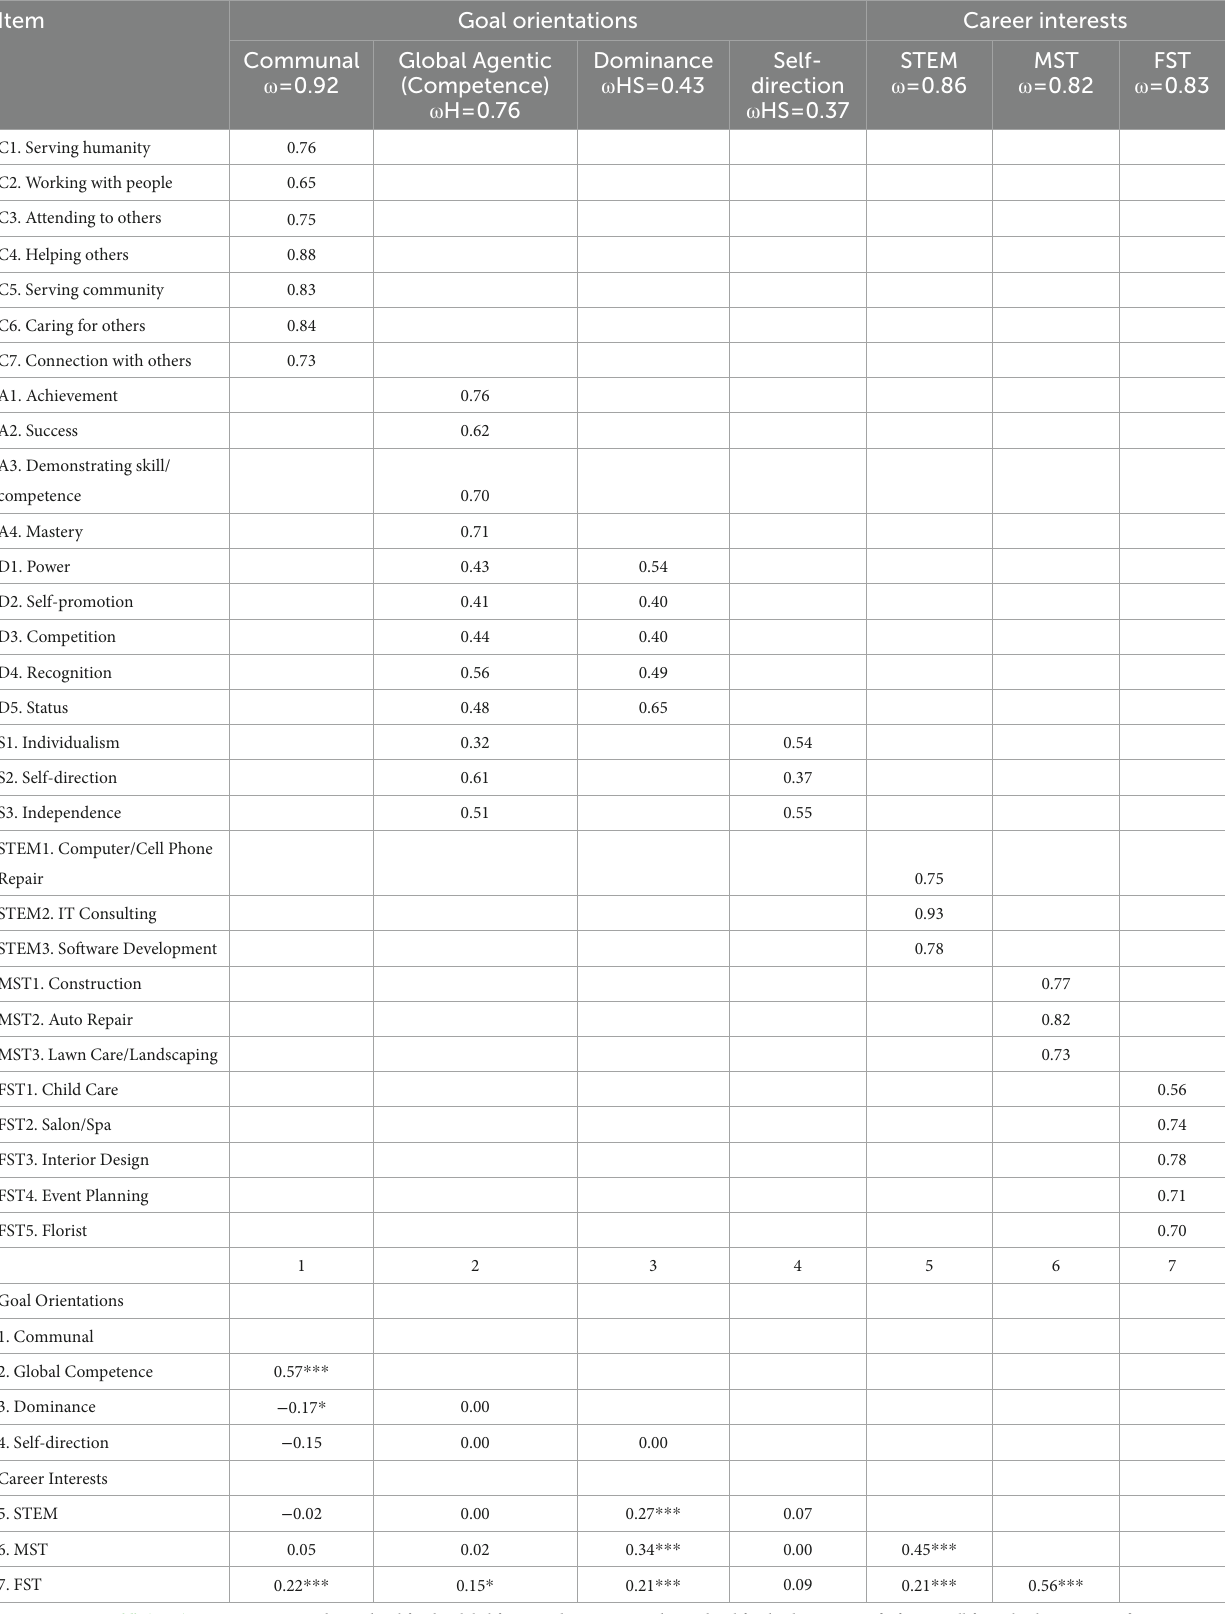
TABLE 3 Standardized factor loadings, reliability estimates, and correlations among latent factors for the final measurement model. Item Goal